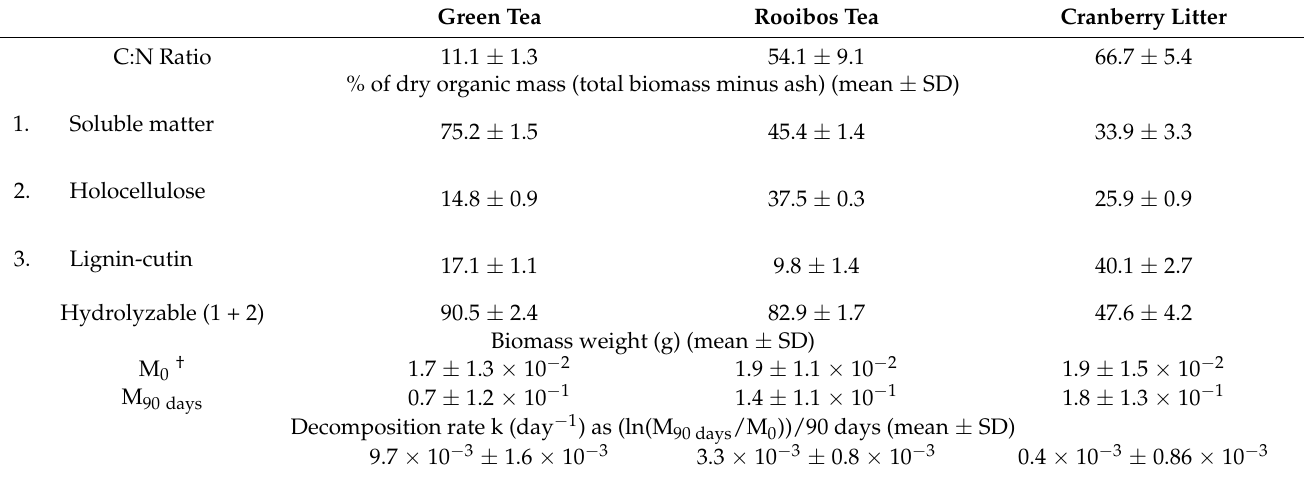
Table 3. Properties of teas and litter materials (mean ± SD) in the first experiment performed in 2017. Green